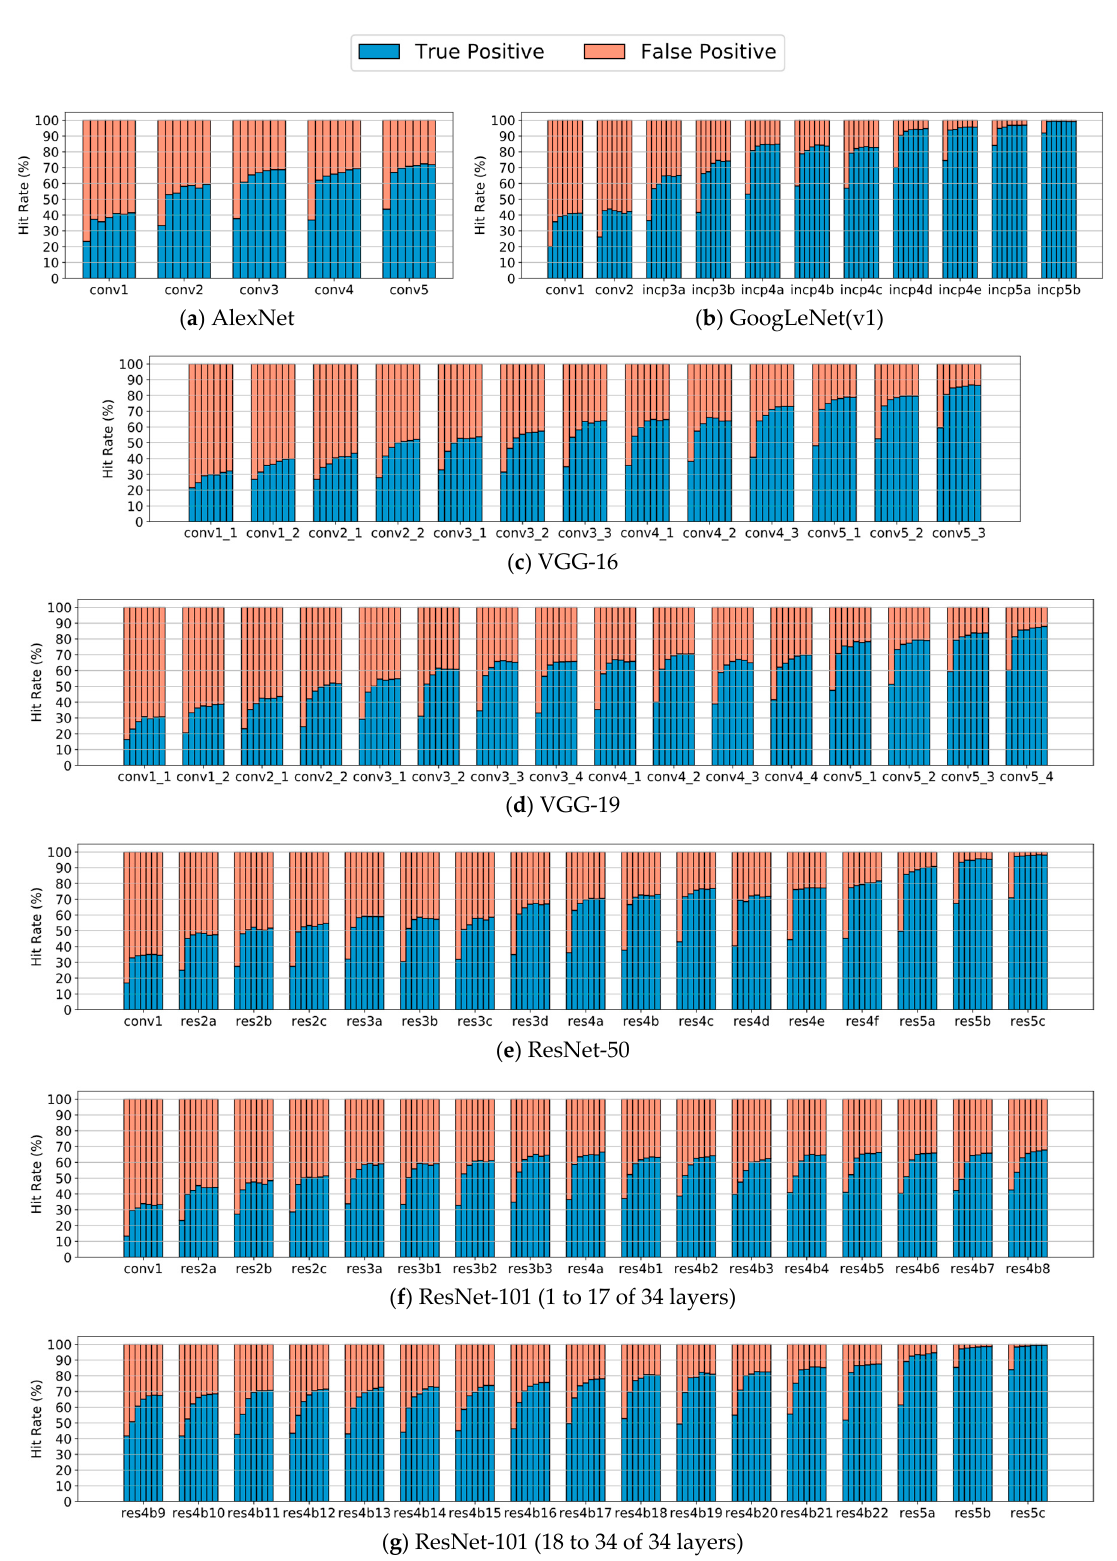
Figure 5. Hit rate of cache without distance threshold. In this case, false positives are also classified by the cache, which are actually Cache Misses .